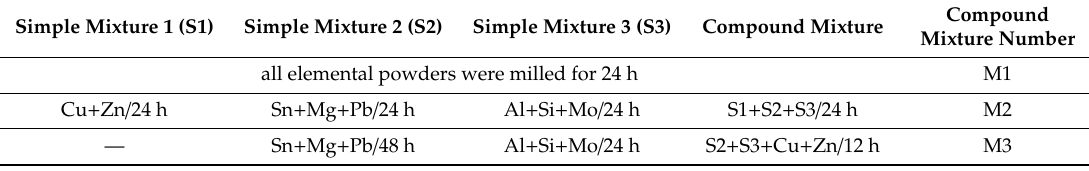
Table 2. Details of mixture of powders preparation